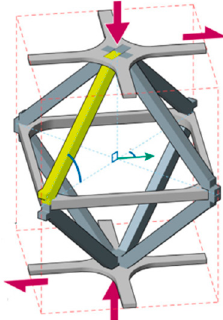
Figure A8. Octet-truss cell [151].